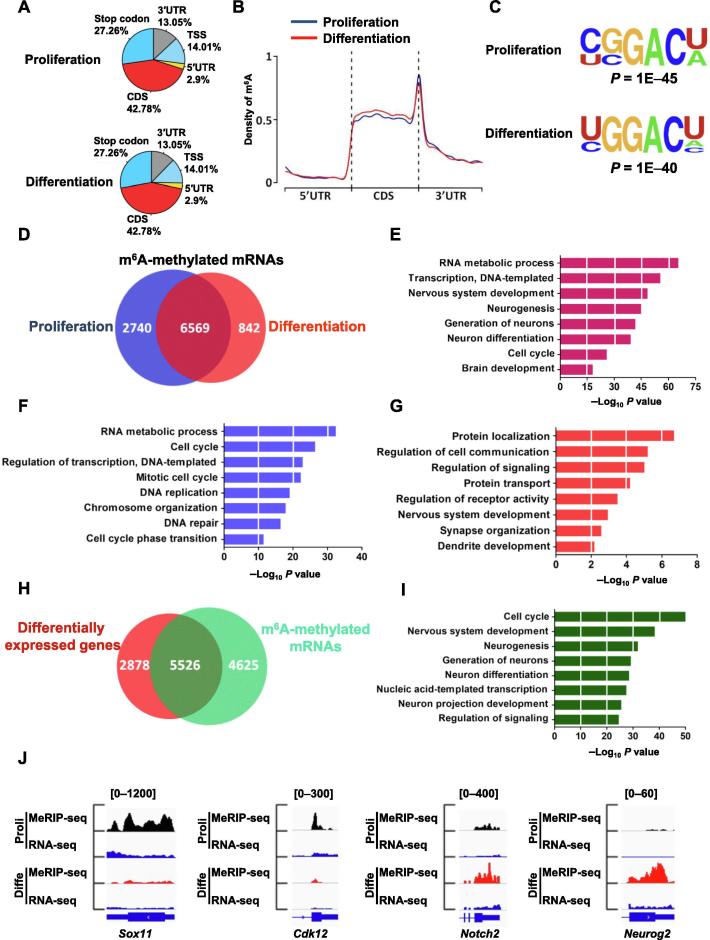
Dynamic m6A modification from proliferation to differentiation of aNSCsTranscriptome-wide distribution of m6A peaks in aNSCs under the conditions of proliferation and differentiation (A, B) (n = 2). The most common sequence motif among m6A peaks during proliferation and differentiation (C). Venn diagram illustrating the m6A modified genes in proliferating and differentiated samples (D). GO analysis of the common m6A modified genes shared between proliferating and differentiated samples (E). GO analysis of the m6A modified specific genes identified in proliferating samples (F) and differentiated samples (G). Venn diagram illustrating the total m6A-tagged genes identified in proliferating and differentiated samples, and differentially expressed genes identified in differentiated samples compared to proliferating samples (H). GO analysis of the common genes shared between m6A tagged genes and differentially expressed genes (I). IGV tracks showing several genes with differential m6A modification from the proliferation to differentiation of aNSCs (J). RNA-seq reads were used as input. TSS, transcription start site; GO, Gene Ontology; Proli, proliferation; Diffe, differentiation; IGV, Integrative Genomics Viewer.